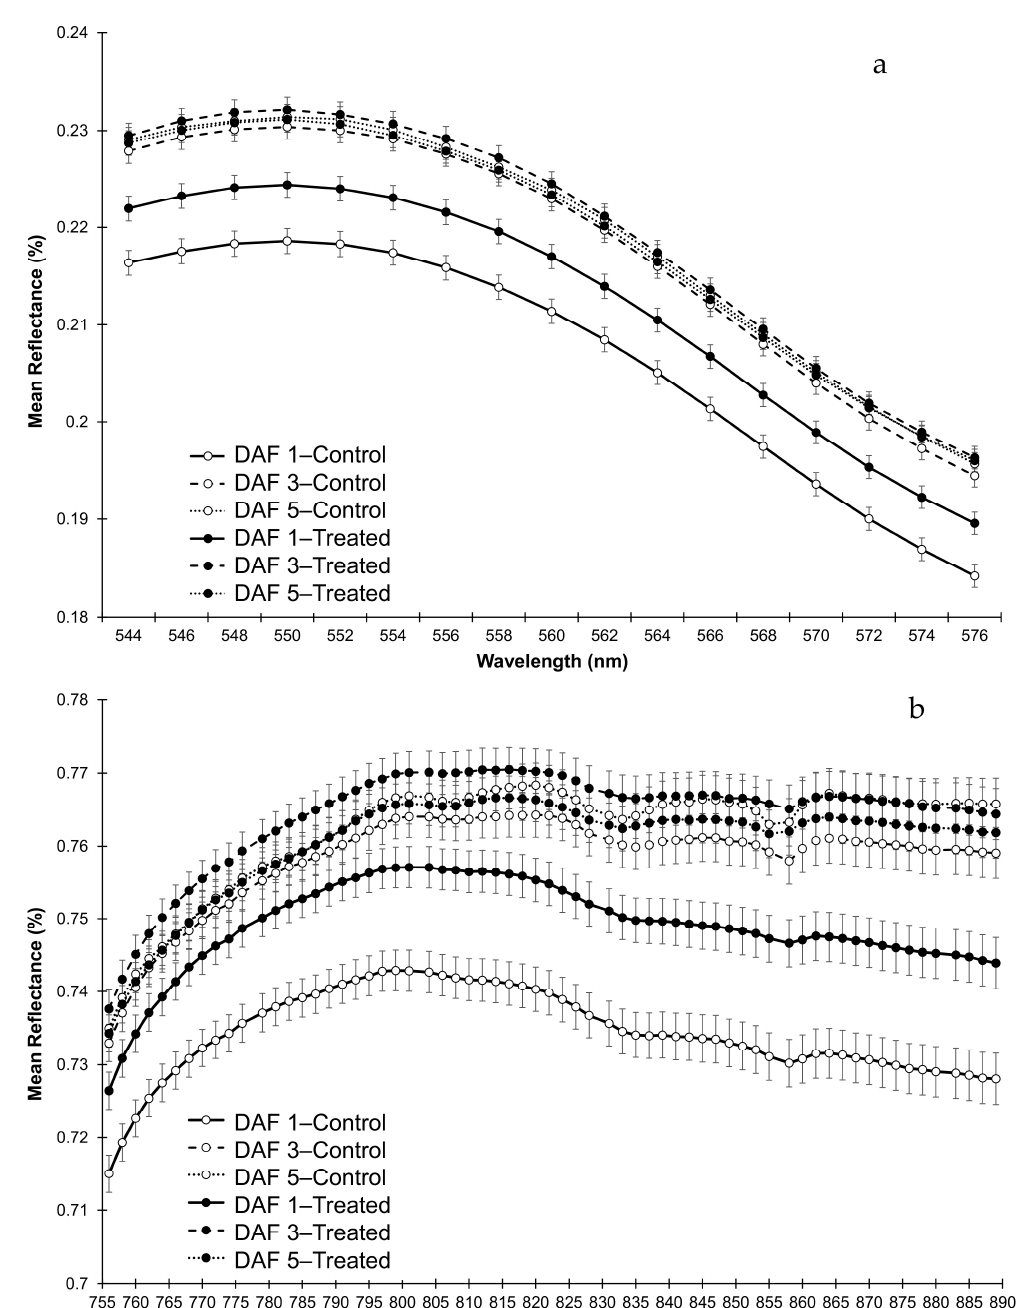
Figure 6. Mean spectral reflectance curves with SE bars ( n = 24) of head components across bands with significant interactions for ( a ) R 544-576 (Green) and for ( b ) R 756–889 (NIR). For leaves, mean spectra for R 394 and R 396 in the ‘Purple Edge’ ((PE), R 380 – 420 ), and for R 564-641 (Green/ Red) were plotted (Figure 7a,b). In the PE region of the EMS the interaction was a result of significantly lower reflectance in the frost treated leaves compared with control leaves on DAF 1, with reflectance in the frosted leaves becoming significantly higher on DAF 3, with no differences on DAF 5 (Figure 7a). In the Green/Red region, the interaction was a result of a significantly higher reflectance in frosted compared with control leaves on DAF 3, with no significant differences on the other measurement dates (Figure 7b).